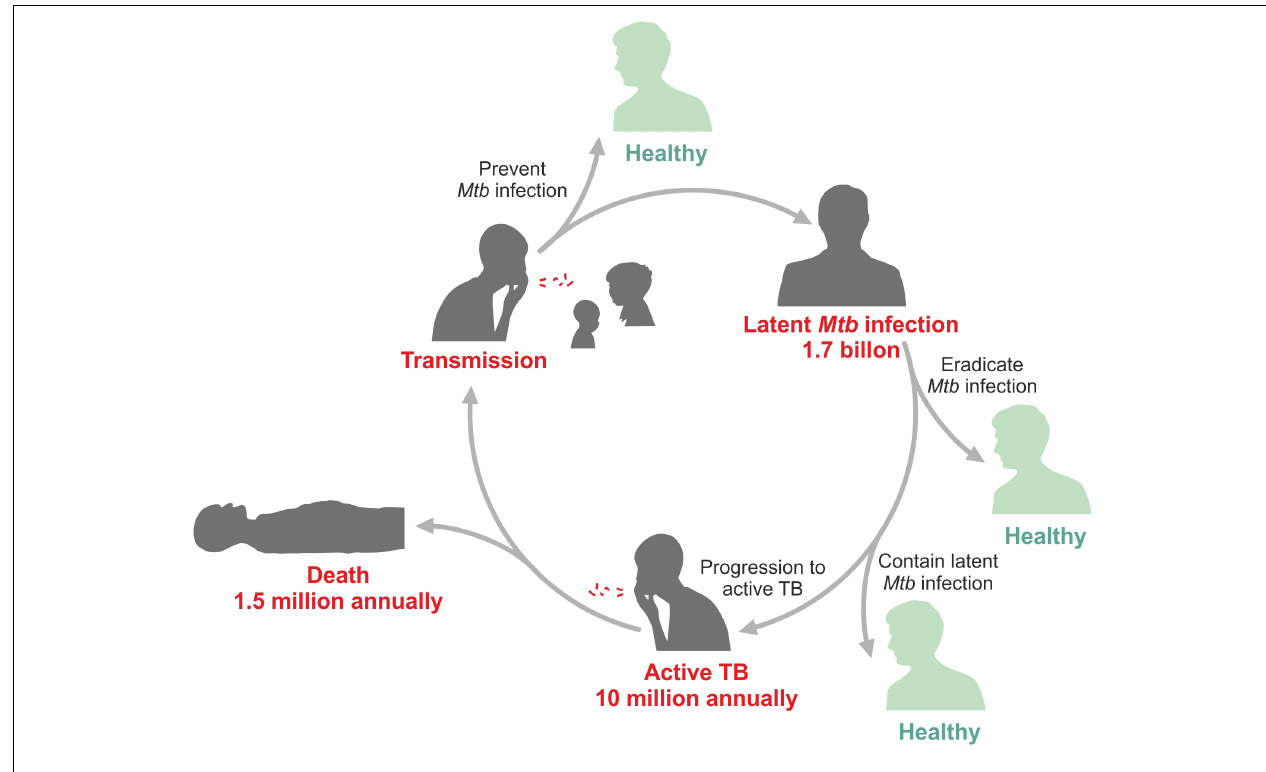
FIGURE 1 | Epidemiologic data for tuberculosis